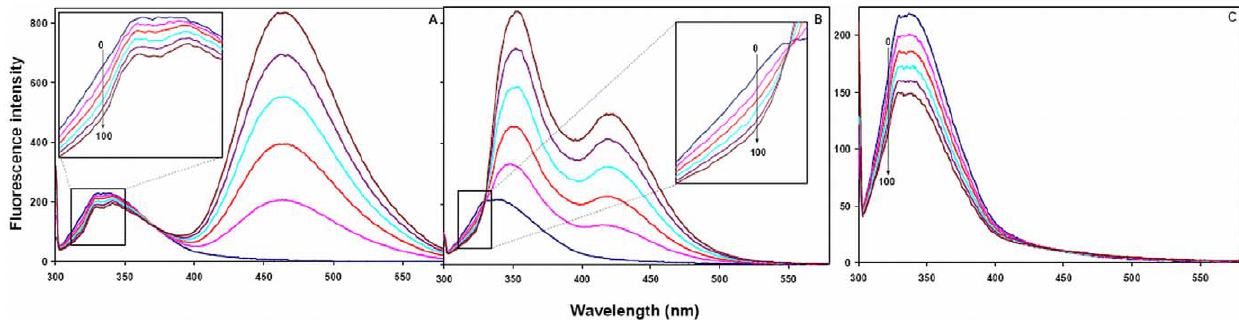
Figure 3. Fluorescence quenching of HSA by (A) 1N, (B) 2N and (C) 8H at 37 6 C. [HSA=2 m M; 1N=2N=8H=0–100 m M]. doi:10.1371/journal.pone.0026186.g003 PLoS ONE |